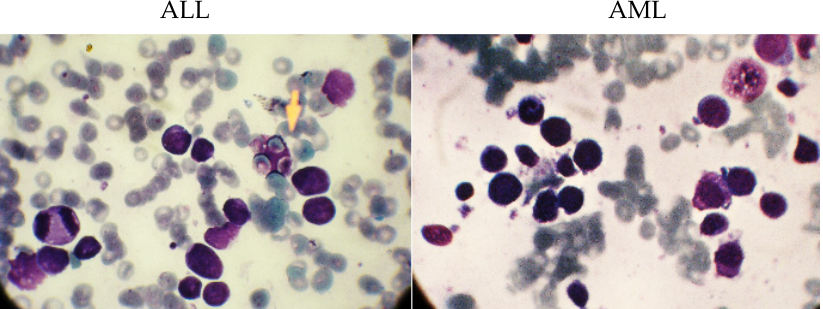
Figure 2. The images related to the two types, including ALL and AML.